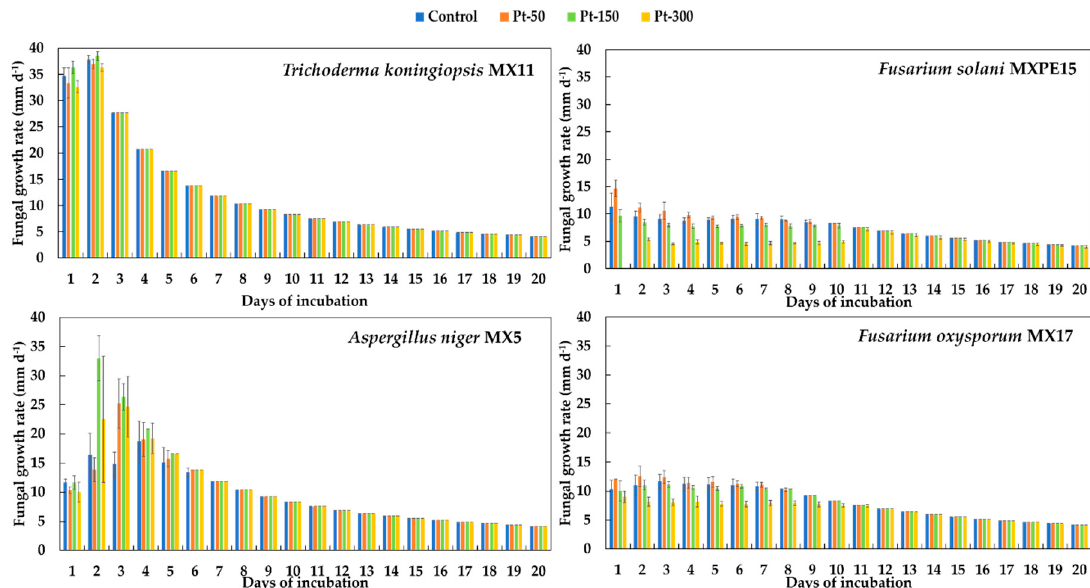
Figure 8. Fungal growth rates of four filamentous fungi strains exposed to four doses of platinum (mg L − 1 ) (n = 3, means ± standard error).